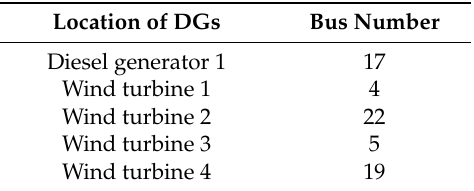
Table 3. Location of distributed generations (DGs) in Scenario